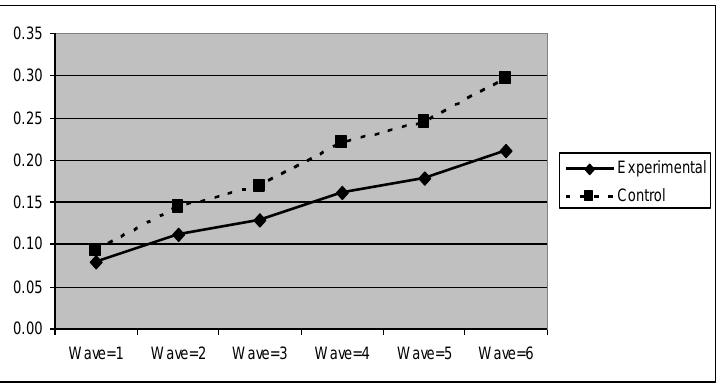
FIGURE 19 . Growth trajectories of the experimental group (Tier 1 participants who perceived the program as effective) and control group using the item score of staying outside as the outcome indicator.